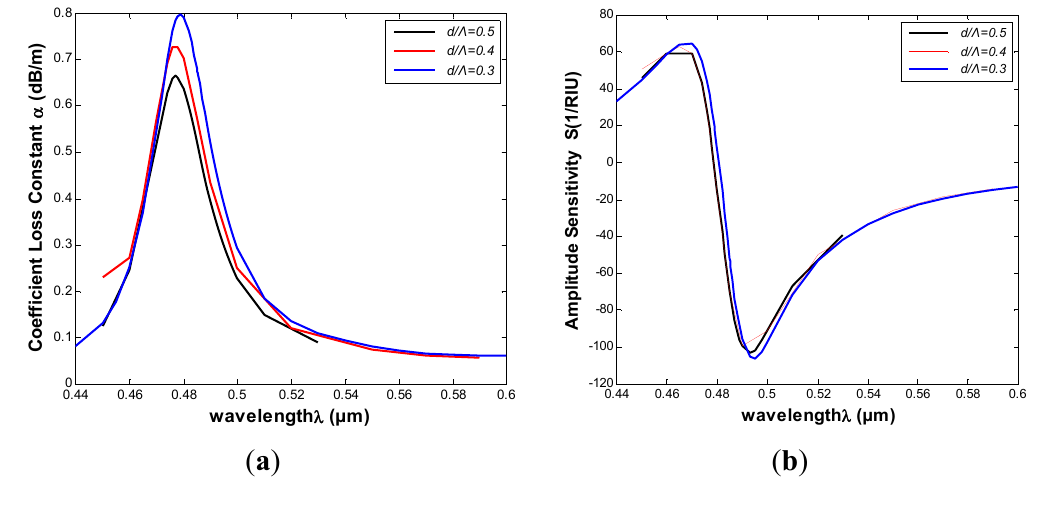
Figure 7. ( a ) The comparison of attenuation constant of the fundamental mode of different diameters of the air holes ( b ) The comparison of intensity detection sensitivity